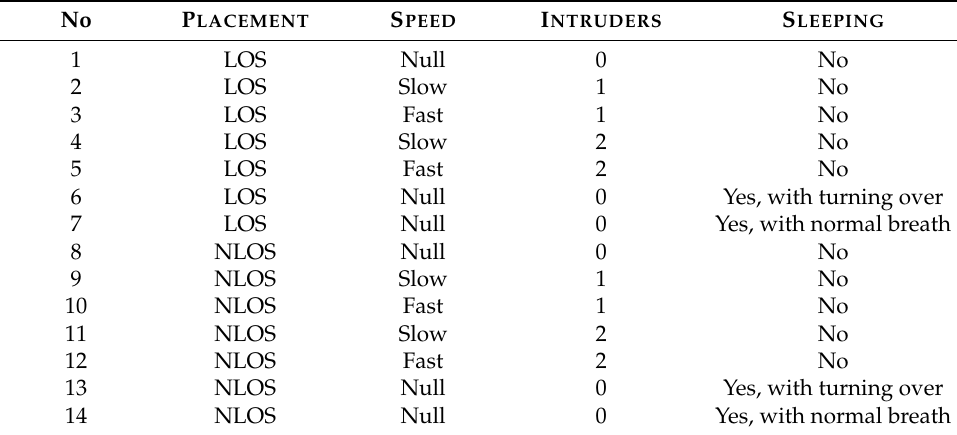
Table 2. Experimental Scenarios and